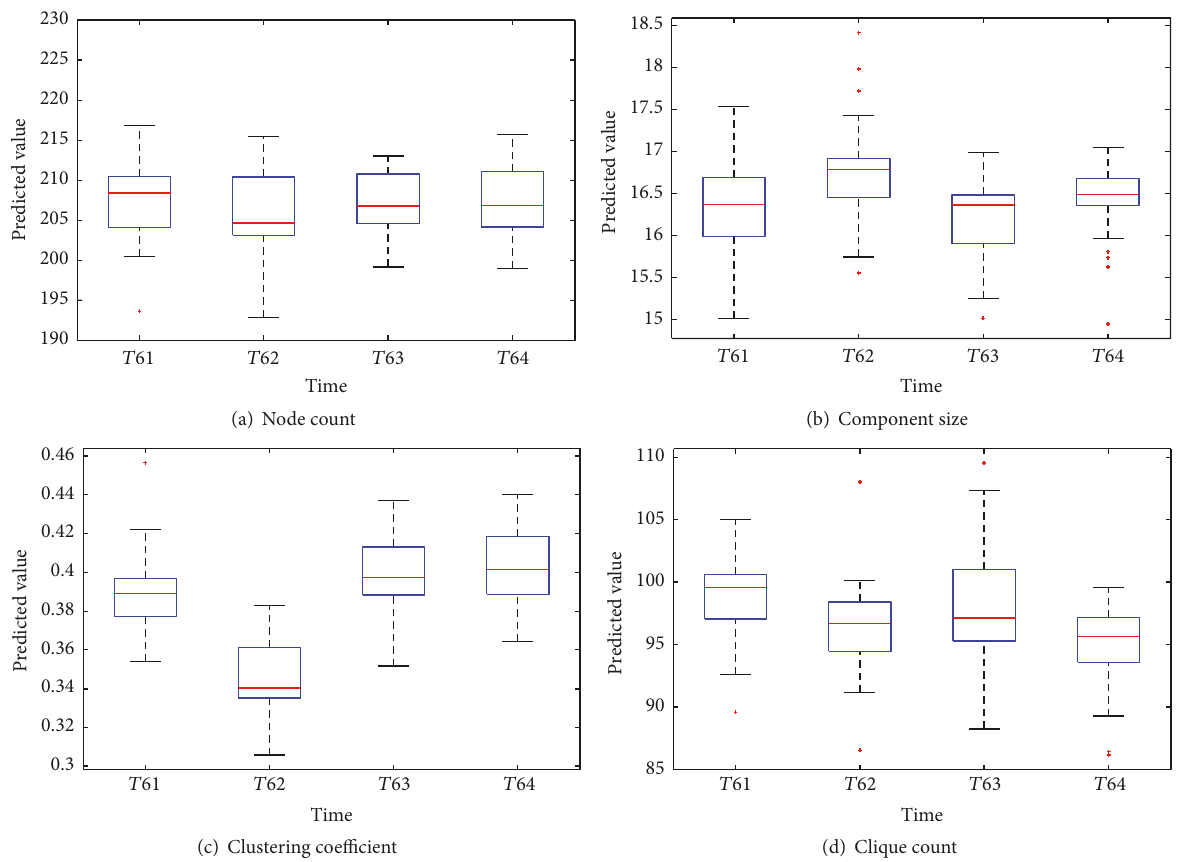
Figure 9: Prediction results of four measures by WNN for the subsequent four timestamps.